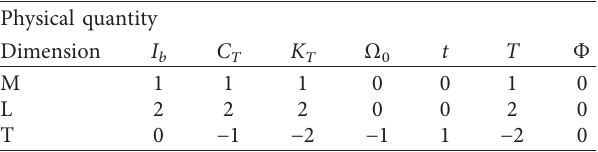
Table 2: Dimensions of the torsional dynamics of the drillstring